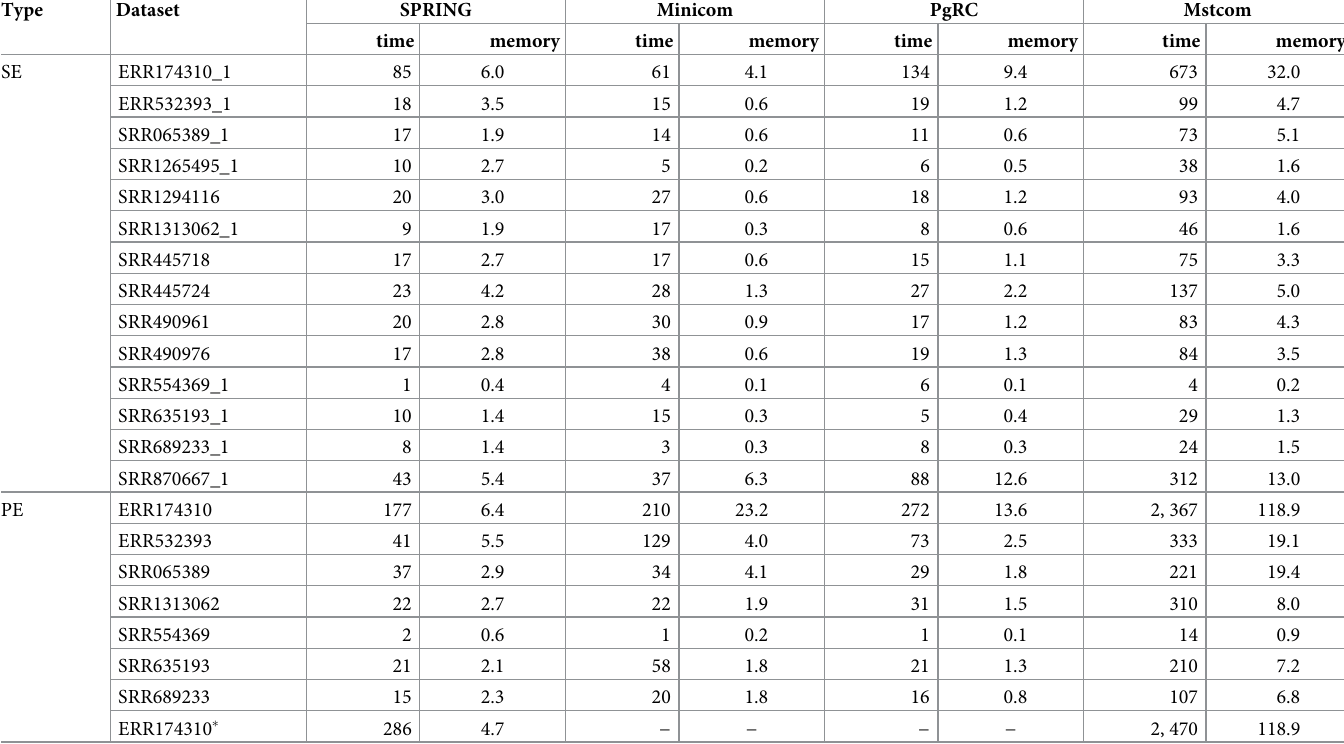
Table 3. Decompression time (seconds) and memory usage (GB) by different methods under the order-free mode. Type Dataset